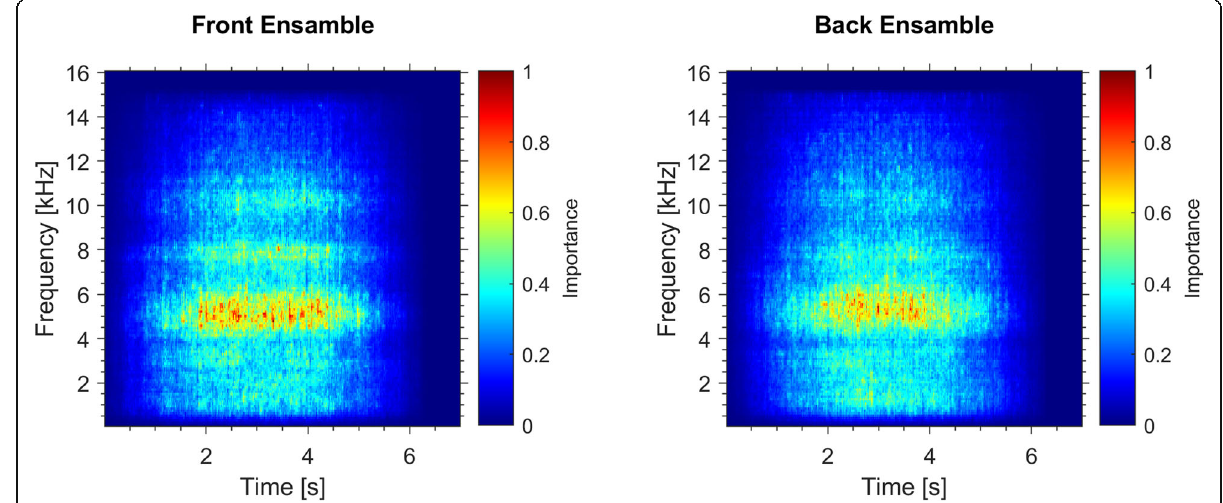
Fig. 18 Gradient attribution maps averaged across experiment repetitions: a front ensemble, b back